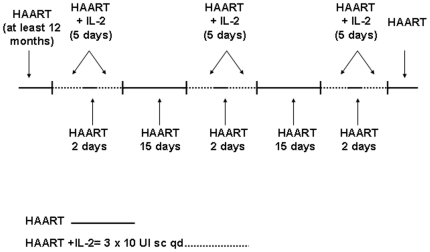
Schedule of IL-2 administration.